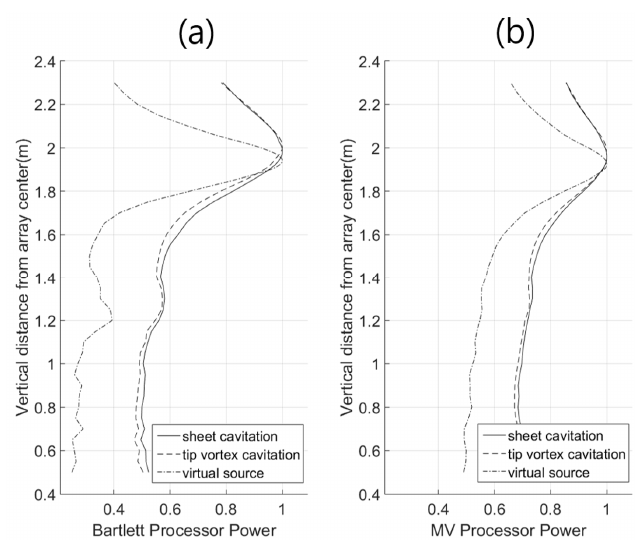
Figure 11. Maximum powers of the Bartlett processor ( a ) and the MV processor ( b ) with respect to depth for the virtual source, the sheet cavitation and the tip vortex cavitation. Remote Sens. 2016 , 8 , 195